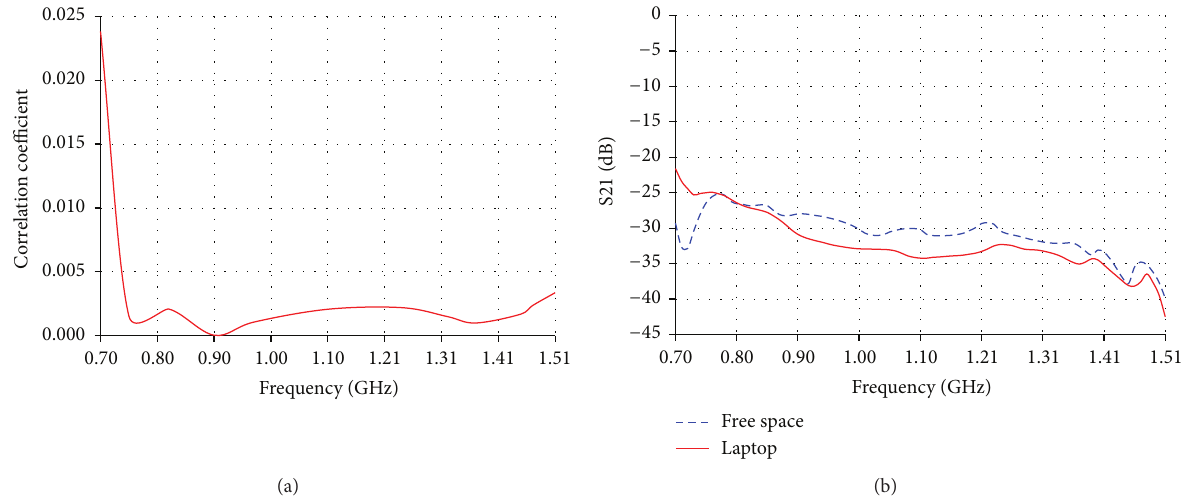
Figure 14: (a) Correlation coefficient and (b) measured isolation between primary and diversity MIMO low band antennas perpendicular to each other and 10cm apart.